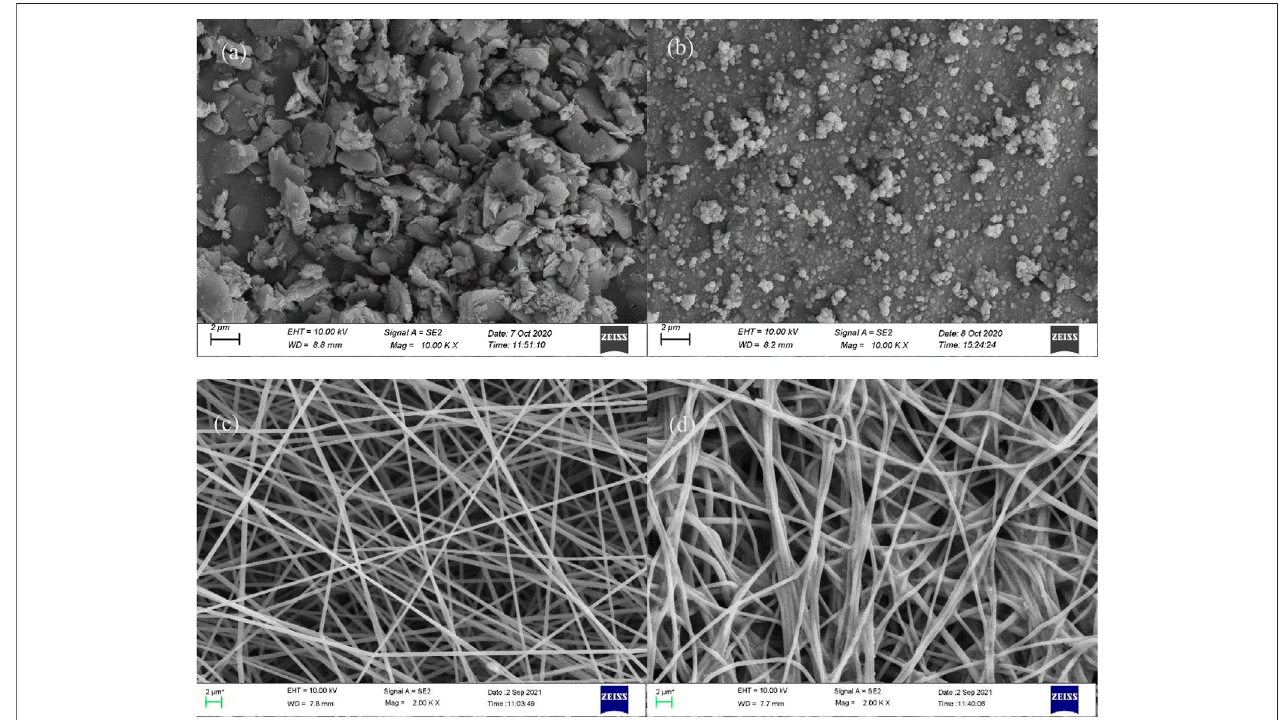
FIGURE 2 | SEM images in different stages. [ (A) Zeolite; (B) SiO 2 /zeolite; (C) PAN-CE@SiO 2 /zeolite nano fi bers; (D) PAN-CE@SiO 2 /zeolite nano fi bers after adsorbing Li( Ι )].